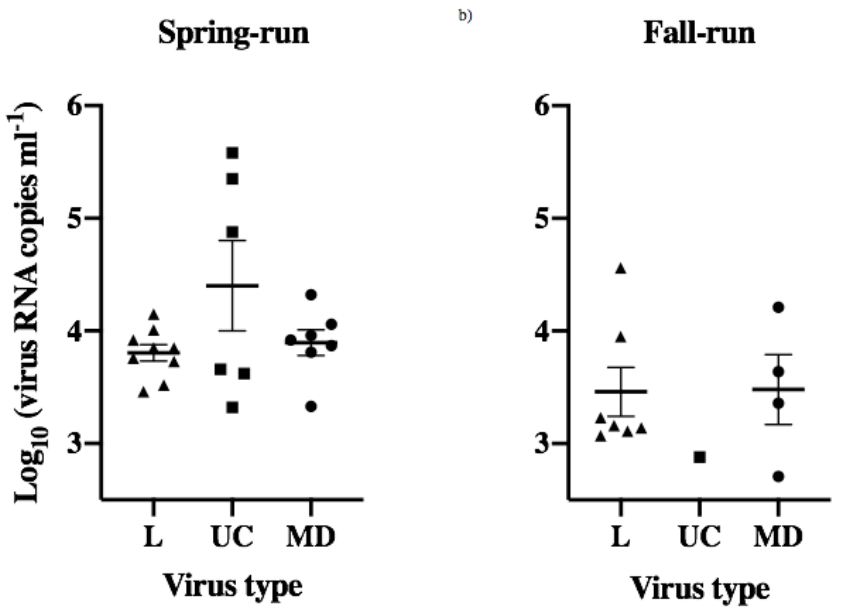
Figure 5. Total quantities of L (triangles), UC (squares) and MD (circles) virus shed by individual juvenile spring- ( a ) and fall-run ( b ) Chinook salmon over the 30-day course of infection. Means ( ± 1 standard error) of total quantities of virus shed by individual fish in each treatment group were calculated for only those fish that shed virus over the 30-day course of infection.